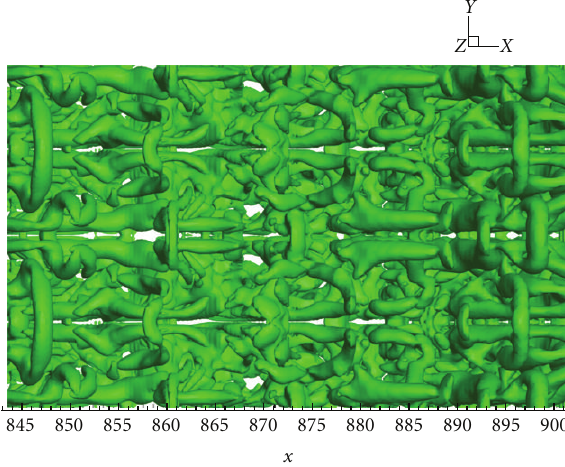
Figure 36: The top ring structure is still symmetric at t = 15 . 0 T .